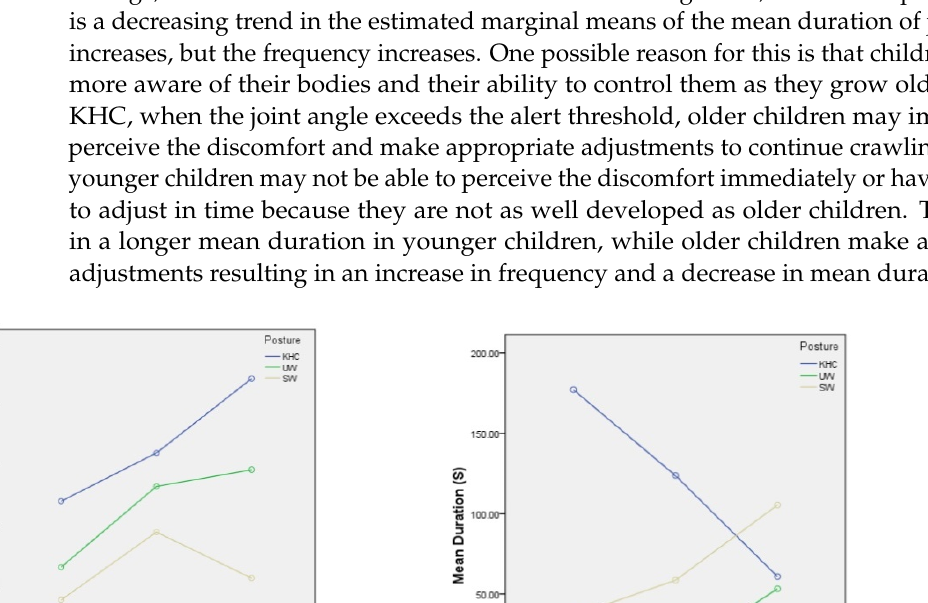
Table 5. Relationship among ages with motion-capture measures.